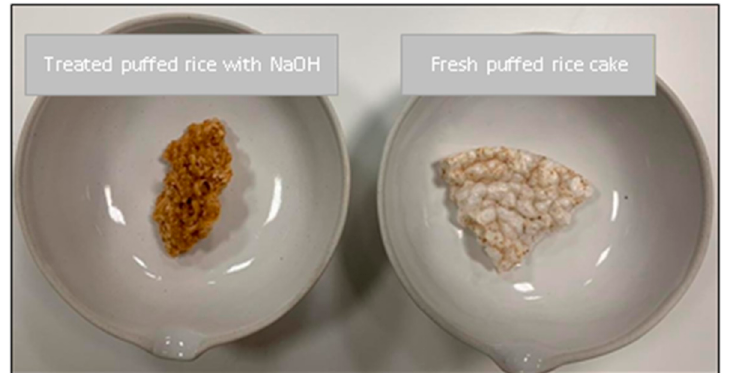
Figure 4. Fresh puffed rice sample and sample treated with sodium hydroxide.